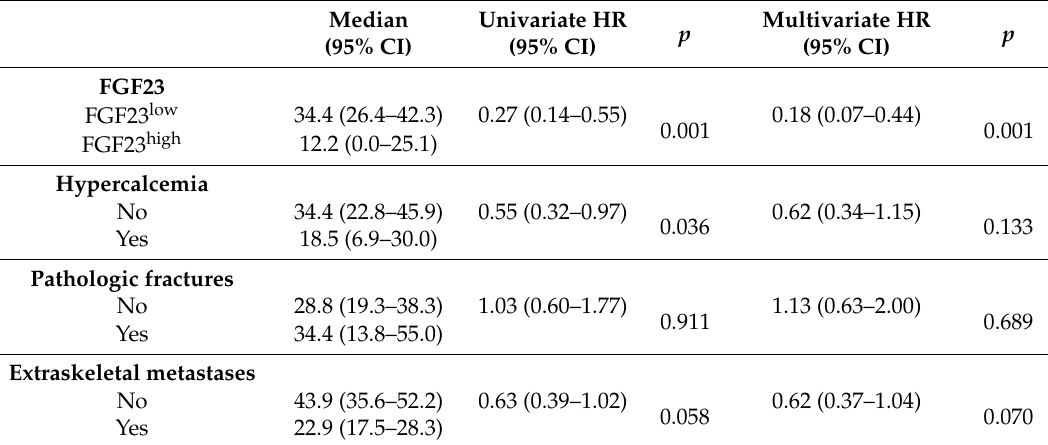
Figure 1. Kaplan-Meier overall survival (OS) curves, according to FGF23 levels. High levels of serum FGRF23 were associated with shorter patient survival. ( p = 0.001; HR 0.27; 95% CI 0.14 − 0.55). Table 2. Cox regression models for OS.